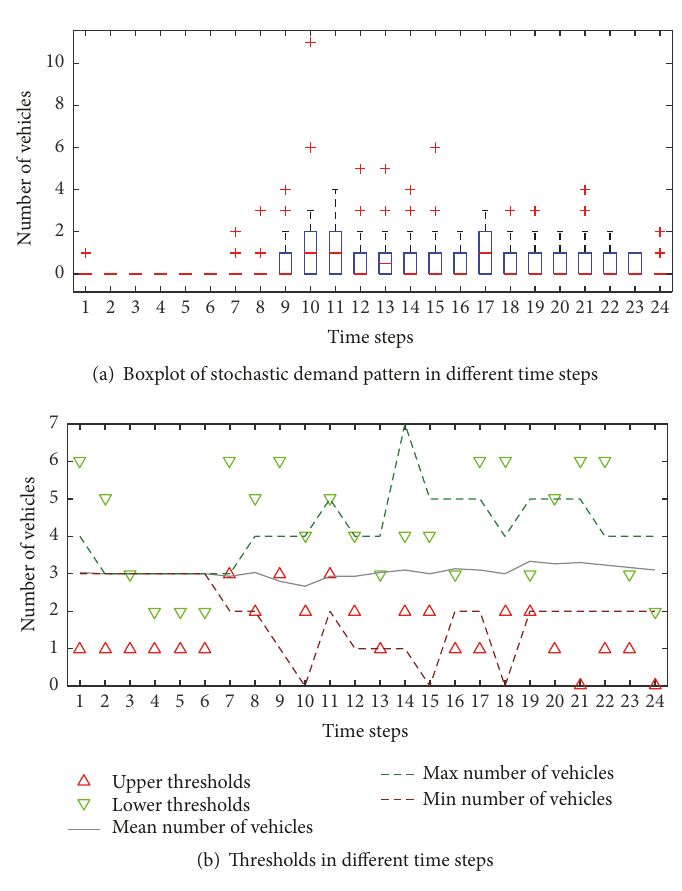
Figure 7: Solution of thresholds for different hours in a